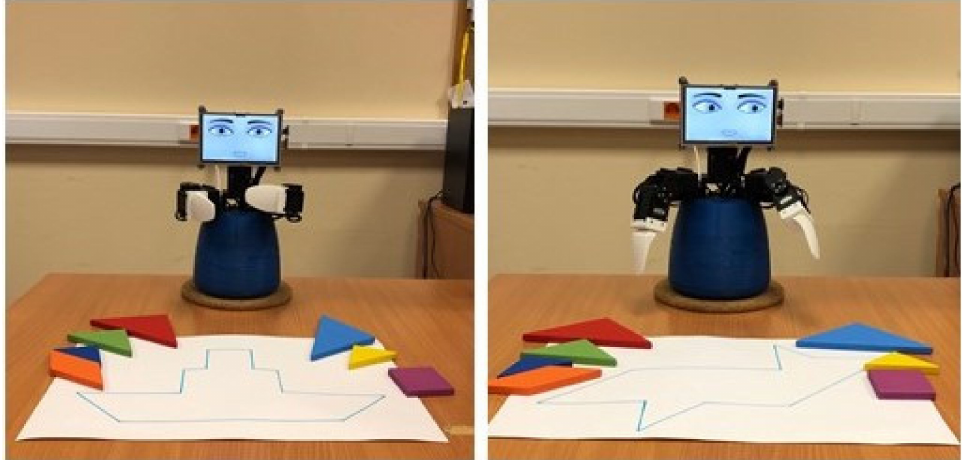
Figure 4. Robot refers to the game element with speech (with ambiguous reference) or with speech and